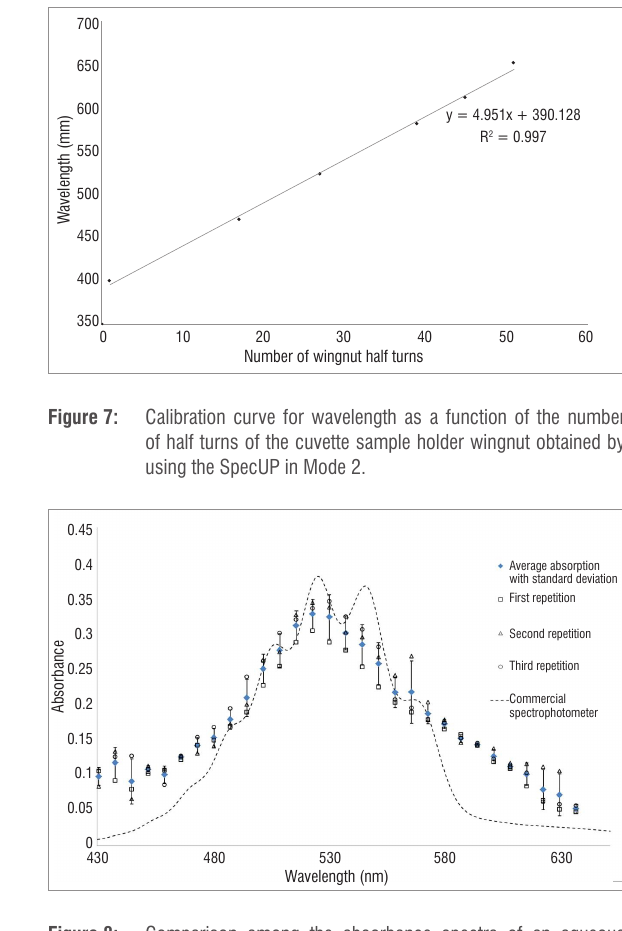
Figure 8: Comparison among the absorbance spectra of an aqueous potassium permanganate solution obtained using the SpecUP in Mode 2 (three replicates) and a commercial spectrophotom- eter, showing the spectral detail and repeatability